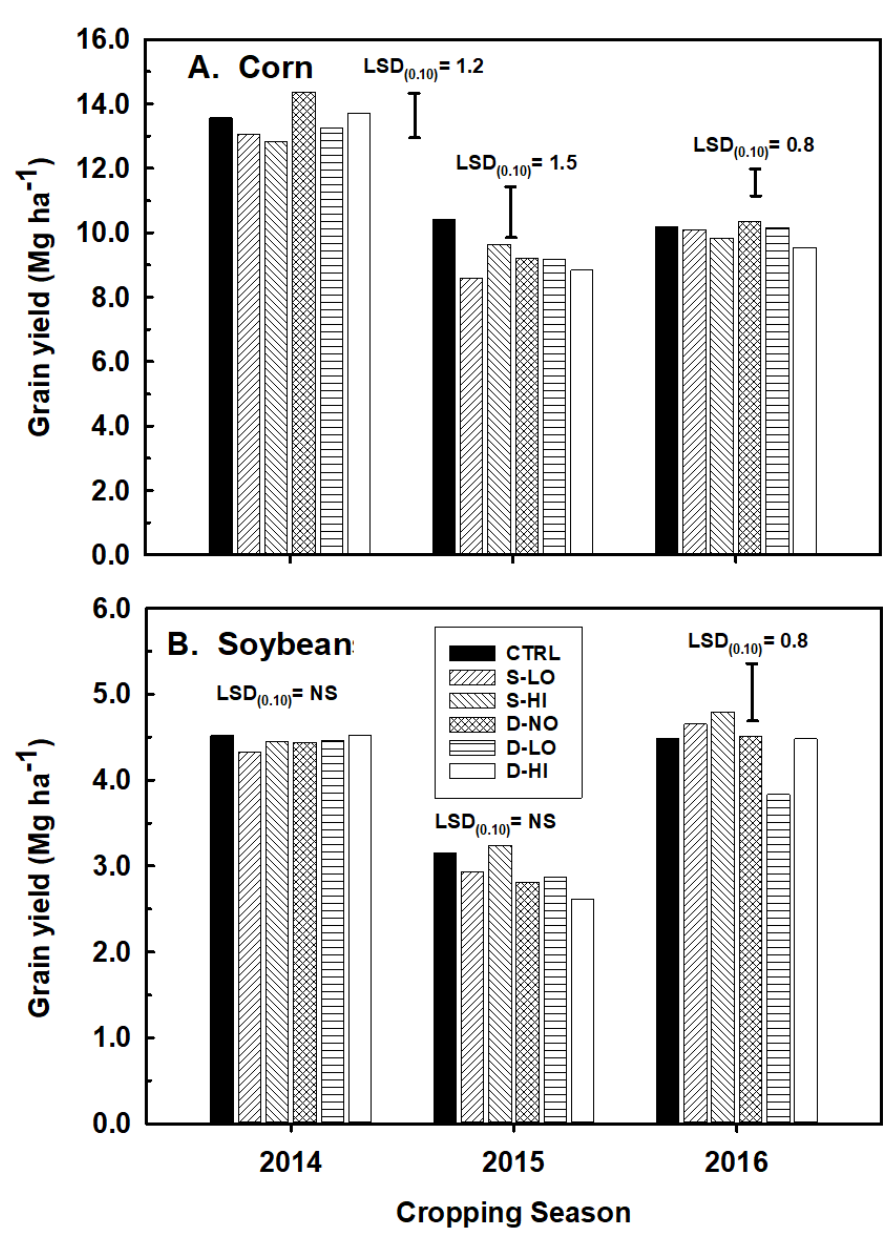
Figure 5. ( A , B ) Trial #2 grain yields (Mg ha −1 ) for ( A ) corn and ( B ) soybeans due to lime treatments from the 2012 to 2016 cropping seasons. LSD (0.10) is least significant differences at p ≤ 0.10. (Abbreviations: CTRL, control; S-LO, surface 3.4 Mg ha −1 ; S-HI, surface 6.7 Mg ha −1 ; D-NO, deep tillage no lime; D-LO, deep placement 3.4 Mg ha −1 ; D-HI, deep placement 6.7 Mg ha −1 ; NS, not significant).